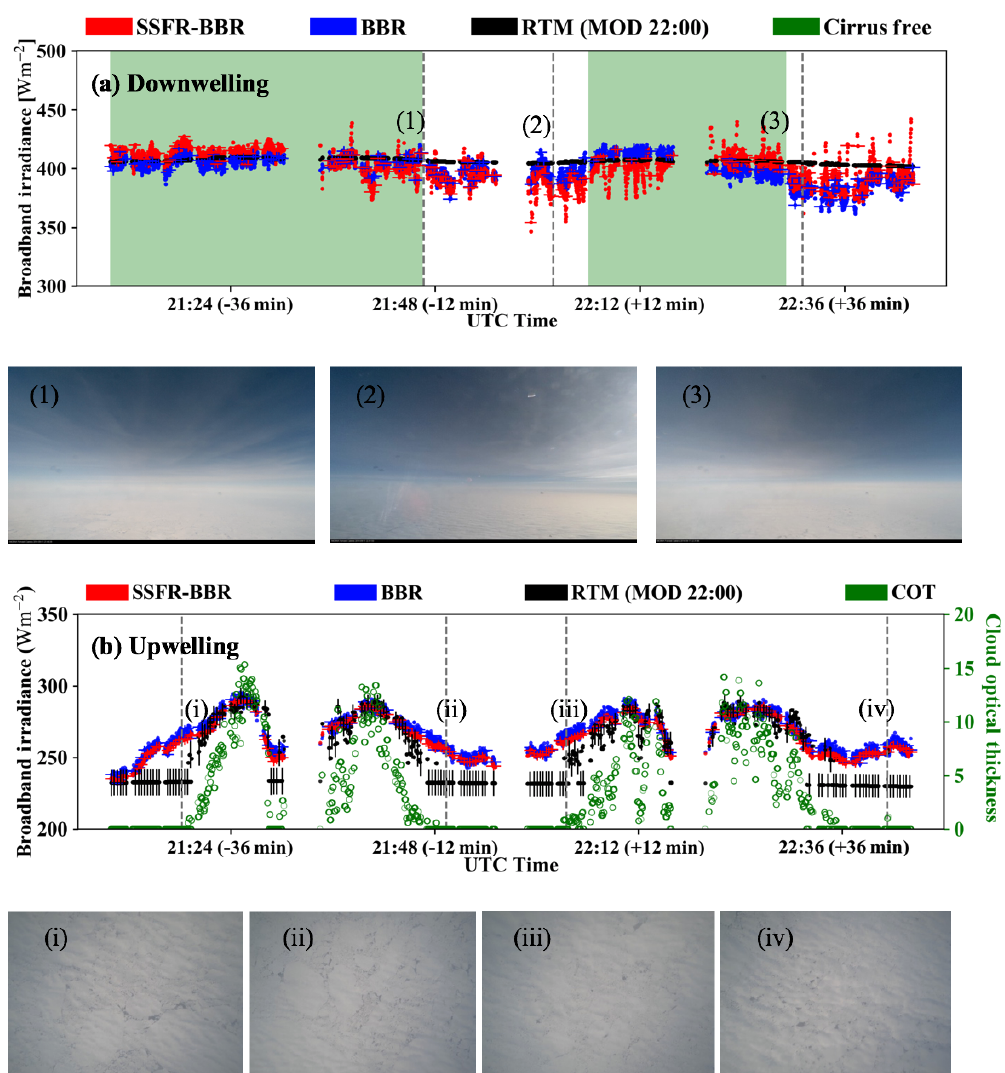
Figure 7. Broadband (a) downwelling and (b) upwelling irradiance from SSFR–BBR, BBR, and MODIS COPs (Terra MODIS at 22:00) RTM calculations on 11 September (above clouds) along with their uncertainties (c) and (d) the histograms. The observed irradiances in- clude a horizontal error bar (indicating the size of the SSFR–BBR FOV) in addition to the vertical error bar (indicating the uncertainty of SSFR–BBR irradiance). The cloud optical thickness from MODIS is indicated in green. The average cloud optical thickness is 6.03. The forward camera images are provided at (1) 21:46:39, (2) 22:01:53, and (3) 22:31:05. The nadir camera images are provided at (i) 21:18:15, (ii) 21:49:22, (iii) 22:03:28, and (iv) 22:41:18UTC. The time differences between aircraft measurements and the MODIS granule are indi- cated in the axis labels. The average flight altitude was 7km and the average aircraft ground speed was 150ms − 1